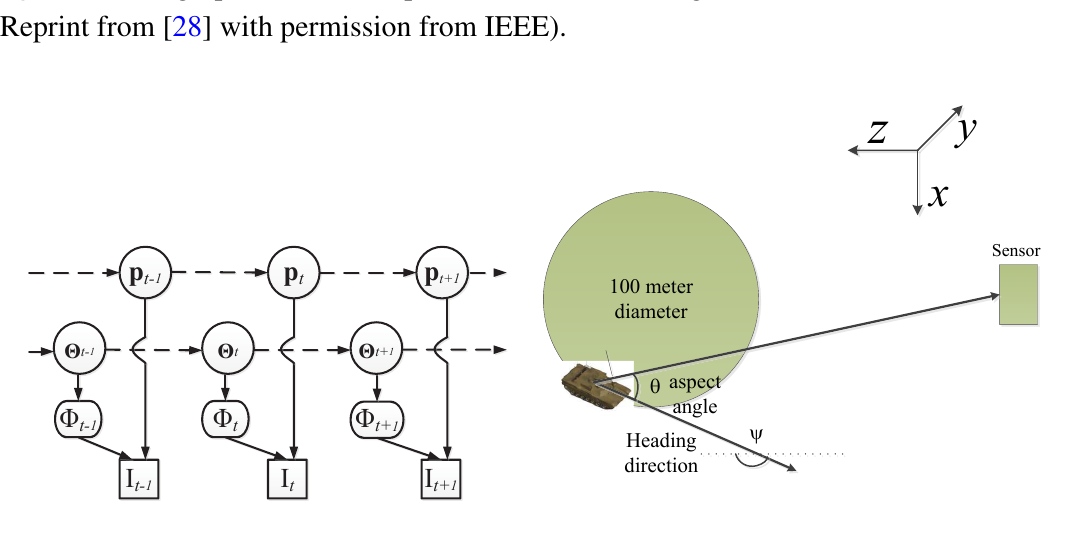
Figure 7. The graphical model representation of ATR-Seg and the 3D camera coordinate. (Reprint from [28] with permission from